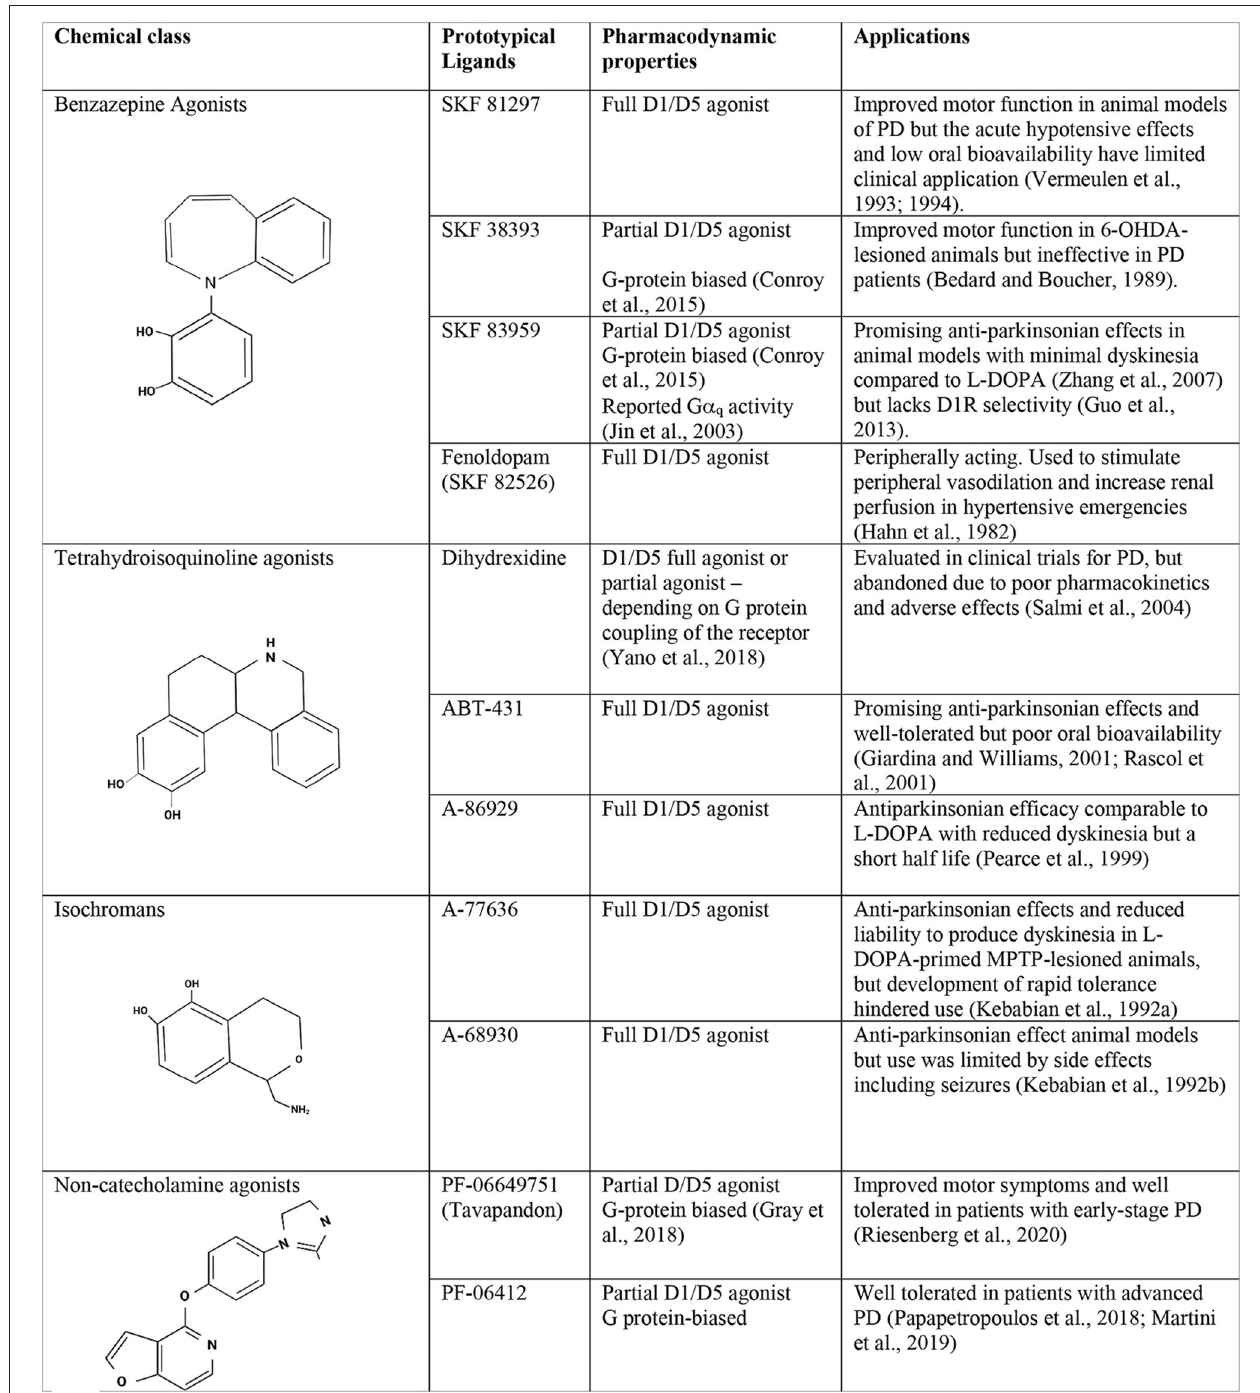
FIGURE 1 | Chemistry and pharmacology of D1R ligands. Chemical structures, pharmacodynamic properties, and tested applications of representative ligands from the principal D1/D5R agonist classes.